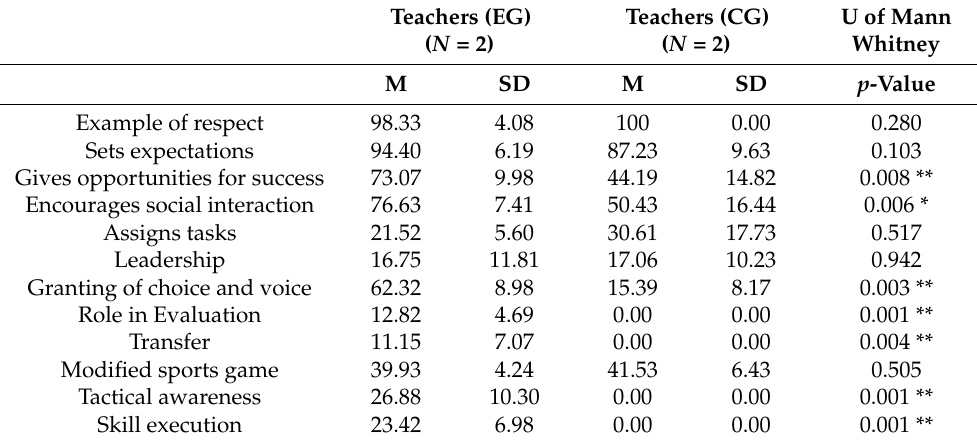
Table 2. Frequencies of model hybridization teaching